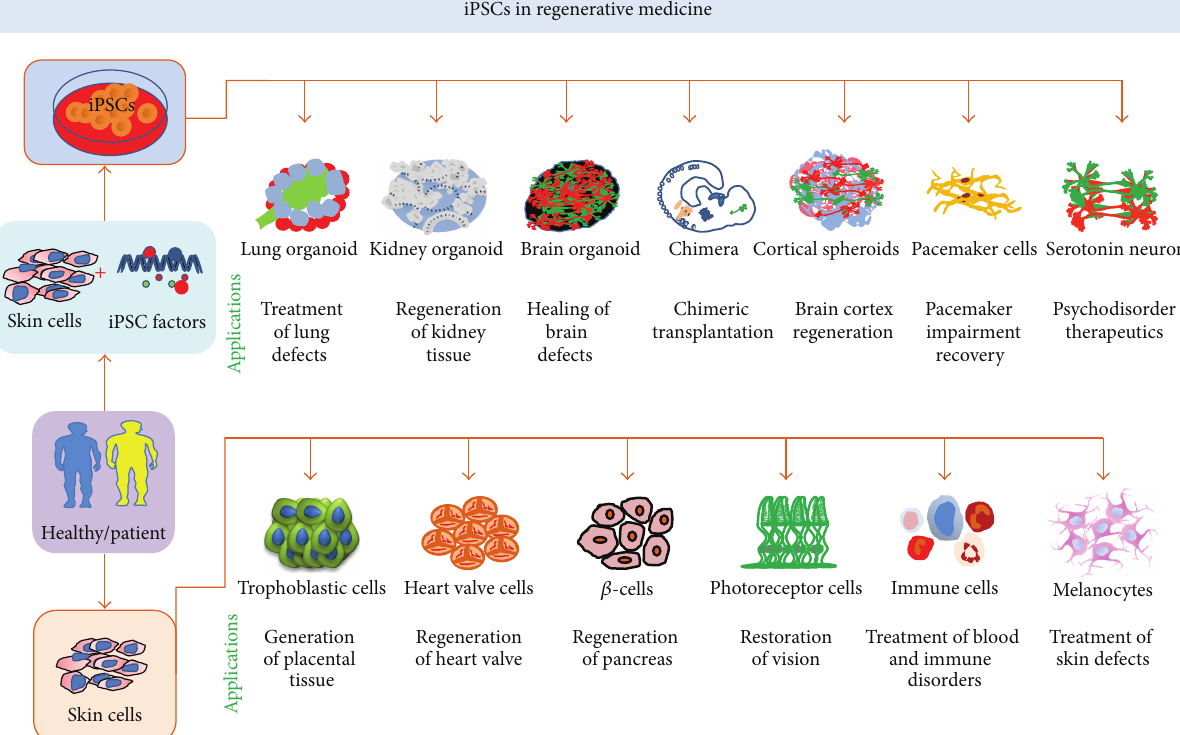
Figure 7: iPSCs in regenerative medicine: using the edge of iPSCs technology, skin fibroblasts and other adult tissues derived, terminally differentiated cells can be transformed into ESCs-like cells. It is possible that adult cells can be transformed into cells of distinct lineages bypassing the phase of pluripotency. The tissue specific defined culture can transform skin cells to become trophoblast, heart valve cells, photoreceptor cells, immune cells, melanocytes, and so forth. ECM complexation with iPSCs enables generation of tissue organoids for lung, kidney, brain, and other organs of the body. Similar to ESCs, iPSCs also can be transformed into cells representing three germ layers such as pacemaker cells and serotonin